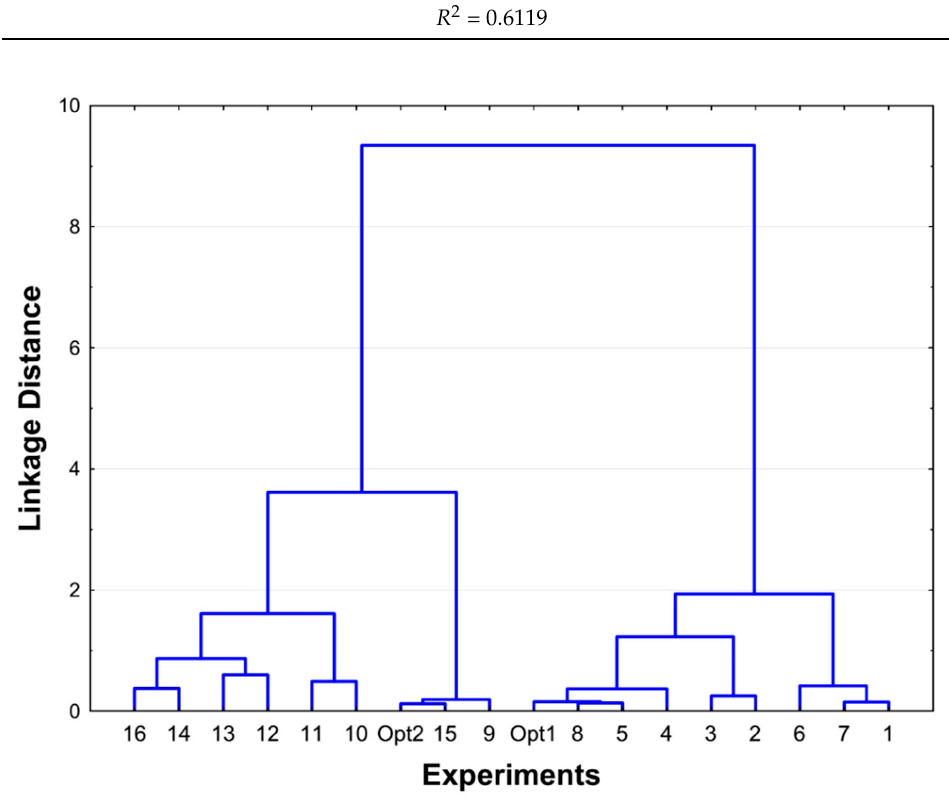
Figure 3. The dendrogram of the clustering of extraction experiments.